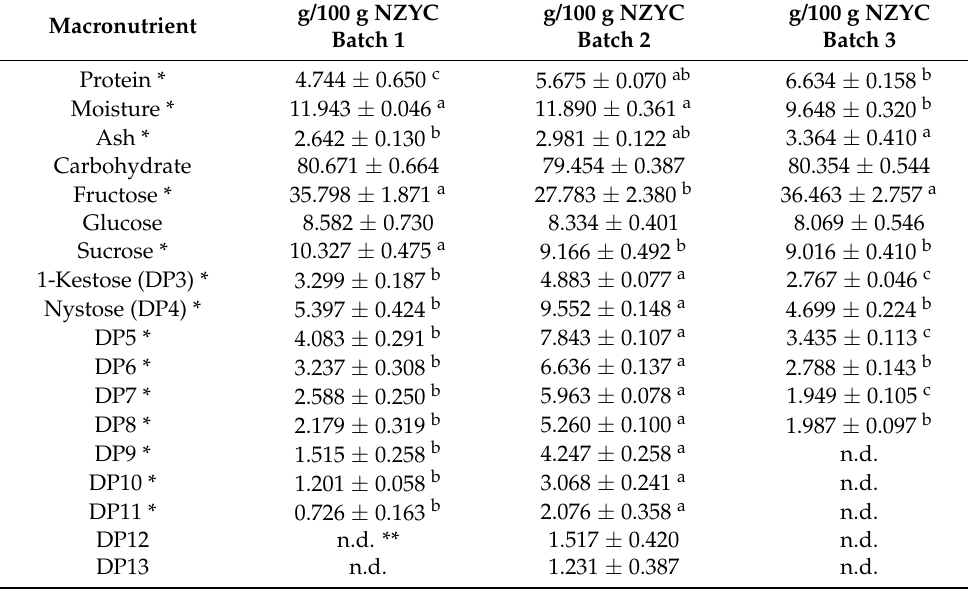
Table 1. Proximate analysis and sugar profile of NZYC ( n =